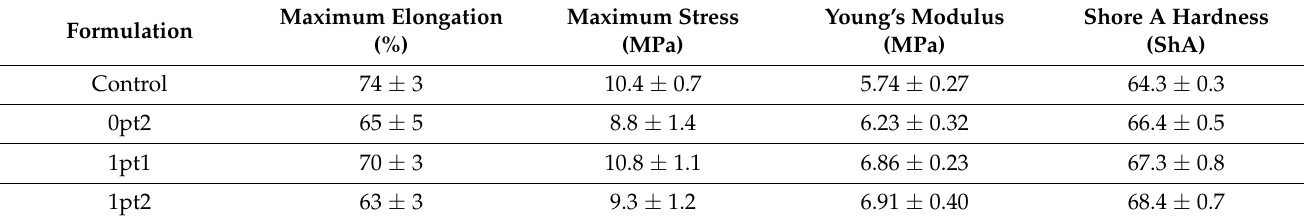
Table 2. Final mechanical properties of the four Sylgard 184 formulations.